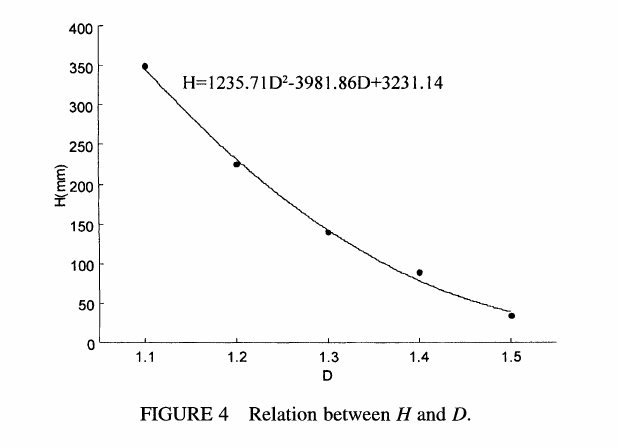
FIGURE 4 Relation between H and D.